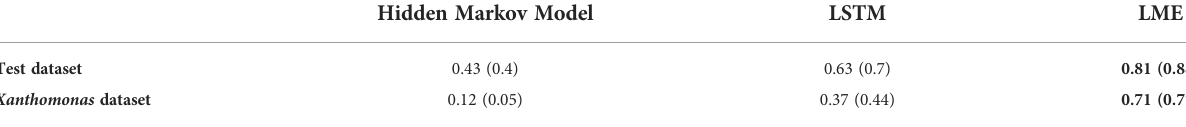
TABLE 1 The performance of the three methods proposed in this work. MCC and AUPRC (in parenthesis) on the test datasets ( “ test dataset ” and “ Xanthomonas dataset ”